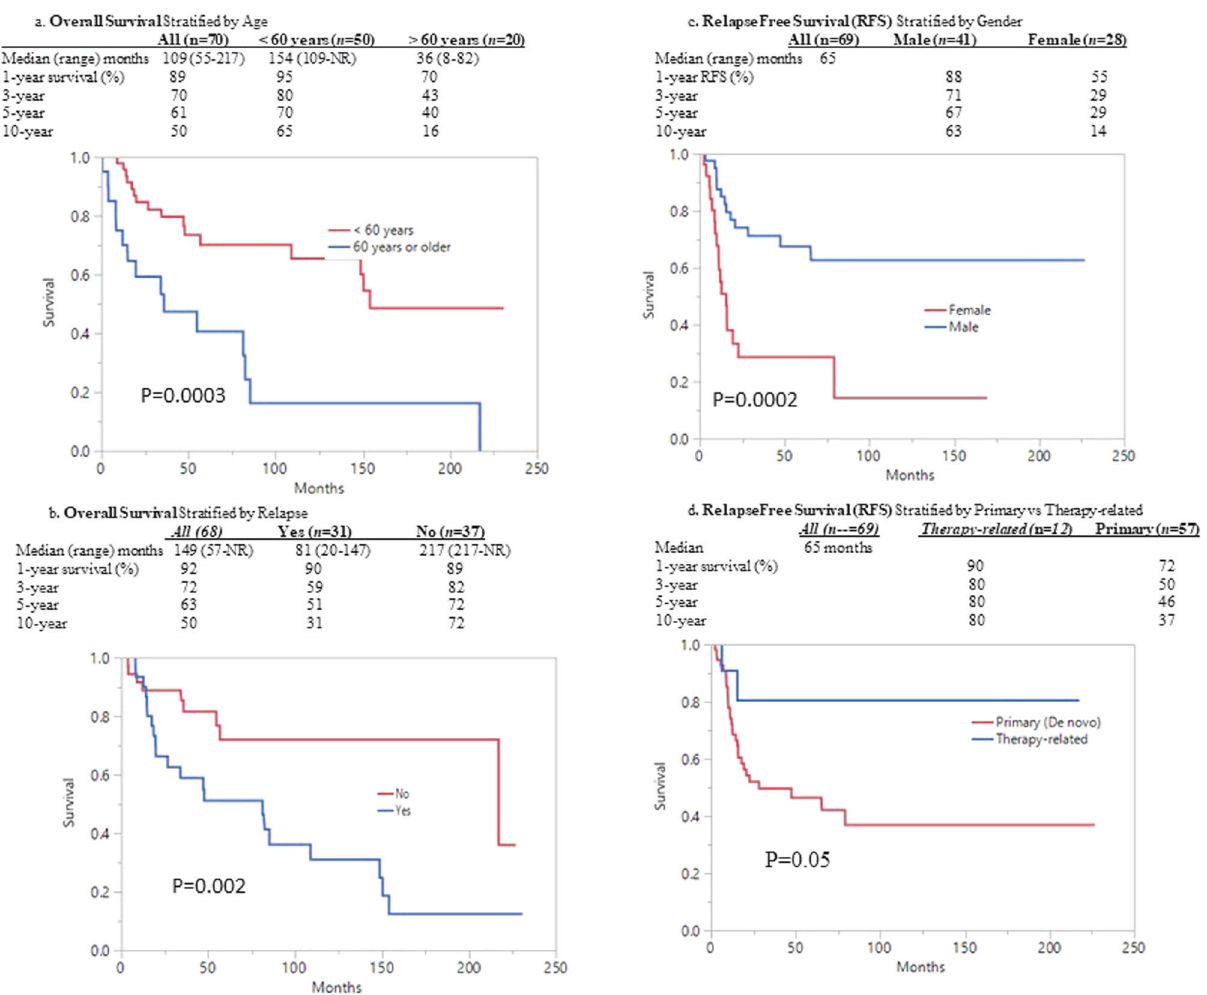
Fig. 1 Overall and Relpase Free Survival in 70 patients with Core-Binding factor AML. a Overall Survival Strati fi ed by Age; b Overall Survival Strati fi ed by Relapse; c Relapse free survival strati fi ed by Gender; d Relapse free survival strati fi ed by primary vs.